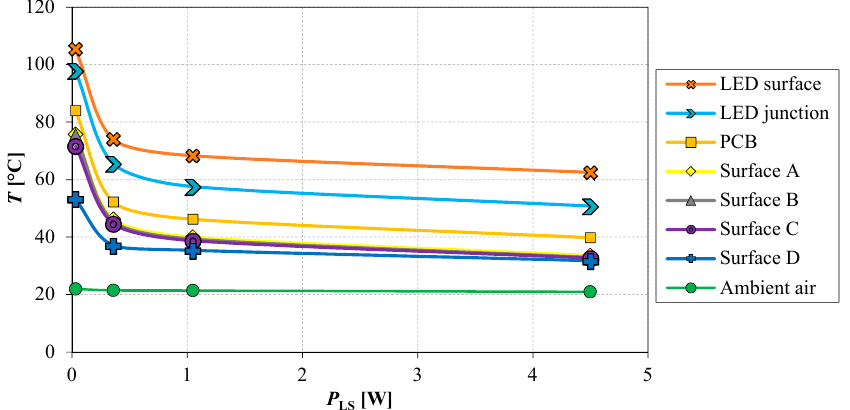
Figure 9. Characteristic temperatures for various values of the input power driving SJA.